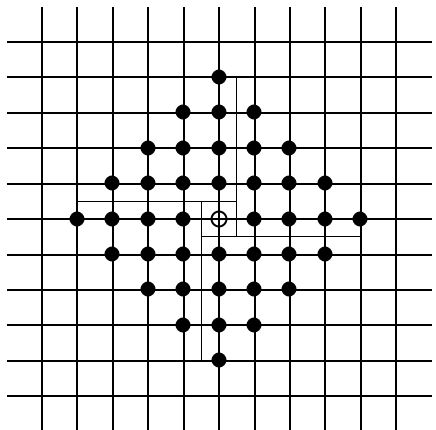
Figure 5 . Neighborhood of size k = 4 on the lattice. It can be easily seen that a player has 4 2 k (1 + k )